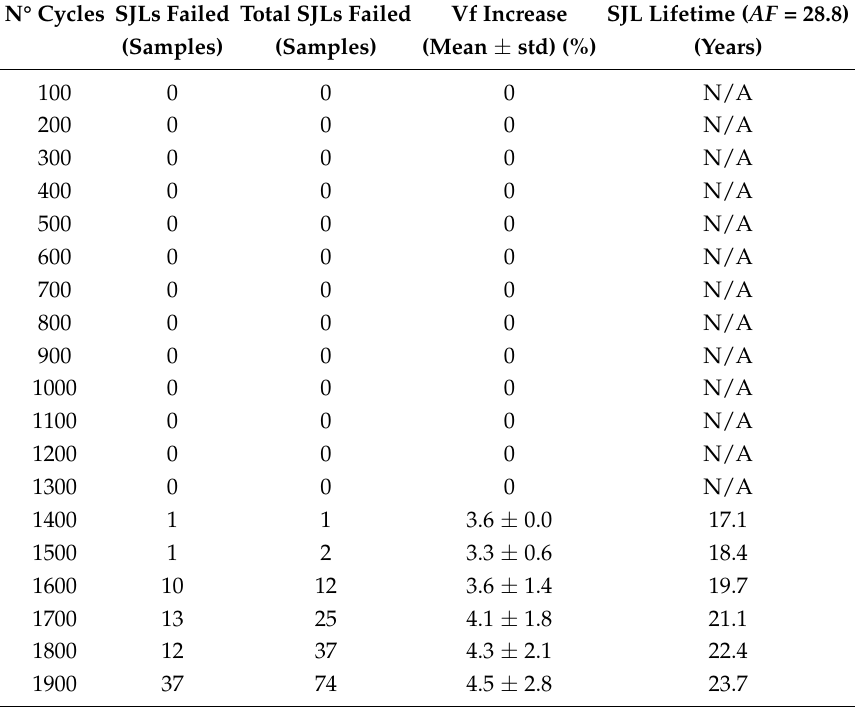
Table 1. The first column presents the thermal cycles, the second the number of failed SJLs at each cycle, and the third the total number of failed at each cycle. The fourth column presents the average increase in Forward Voltage (Vf) and the related standard deviation. Last column reports the SJL